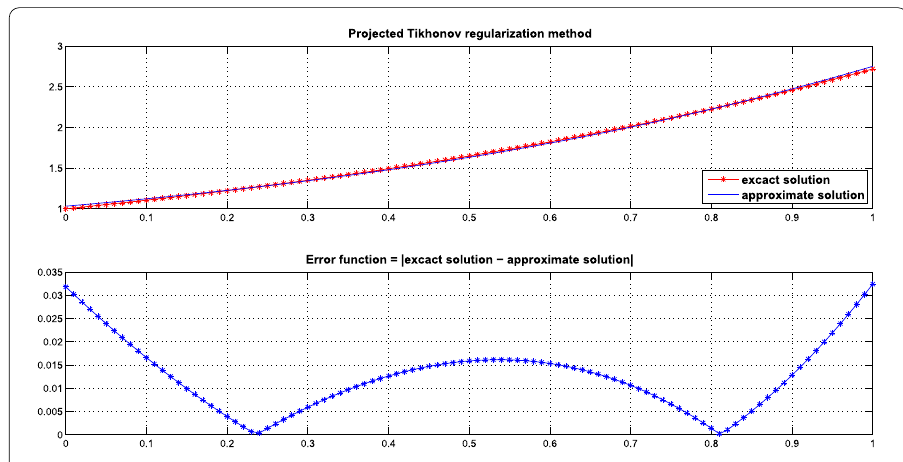
Figure 3 Example 1, noise level = 1/1,000, n = 3.